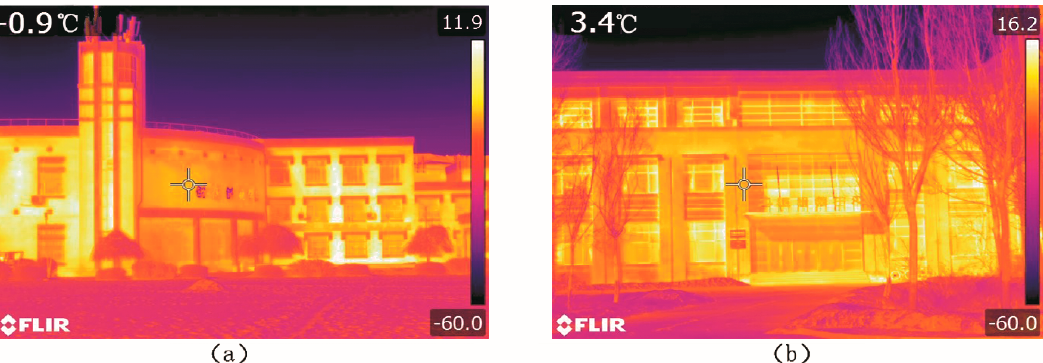
Figure 14. Infrared photos of buildings at measuring points S and H: ( a ) measuring points S; ( b )